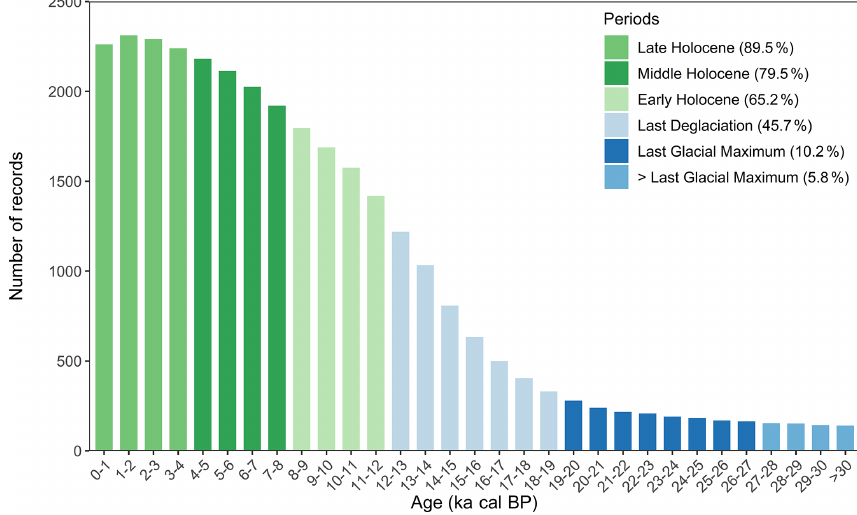
Figure 2. Histogram showing the number of available records in distinct time